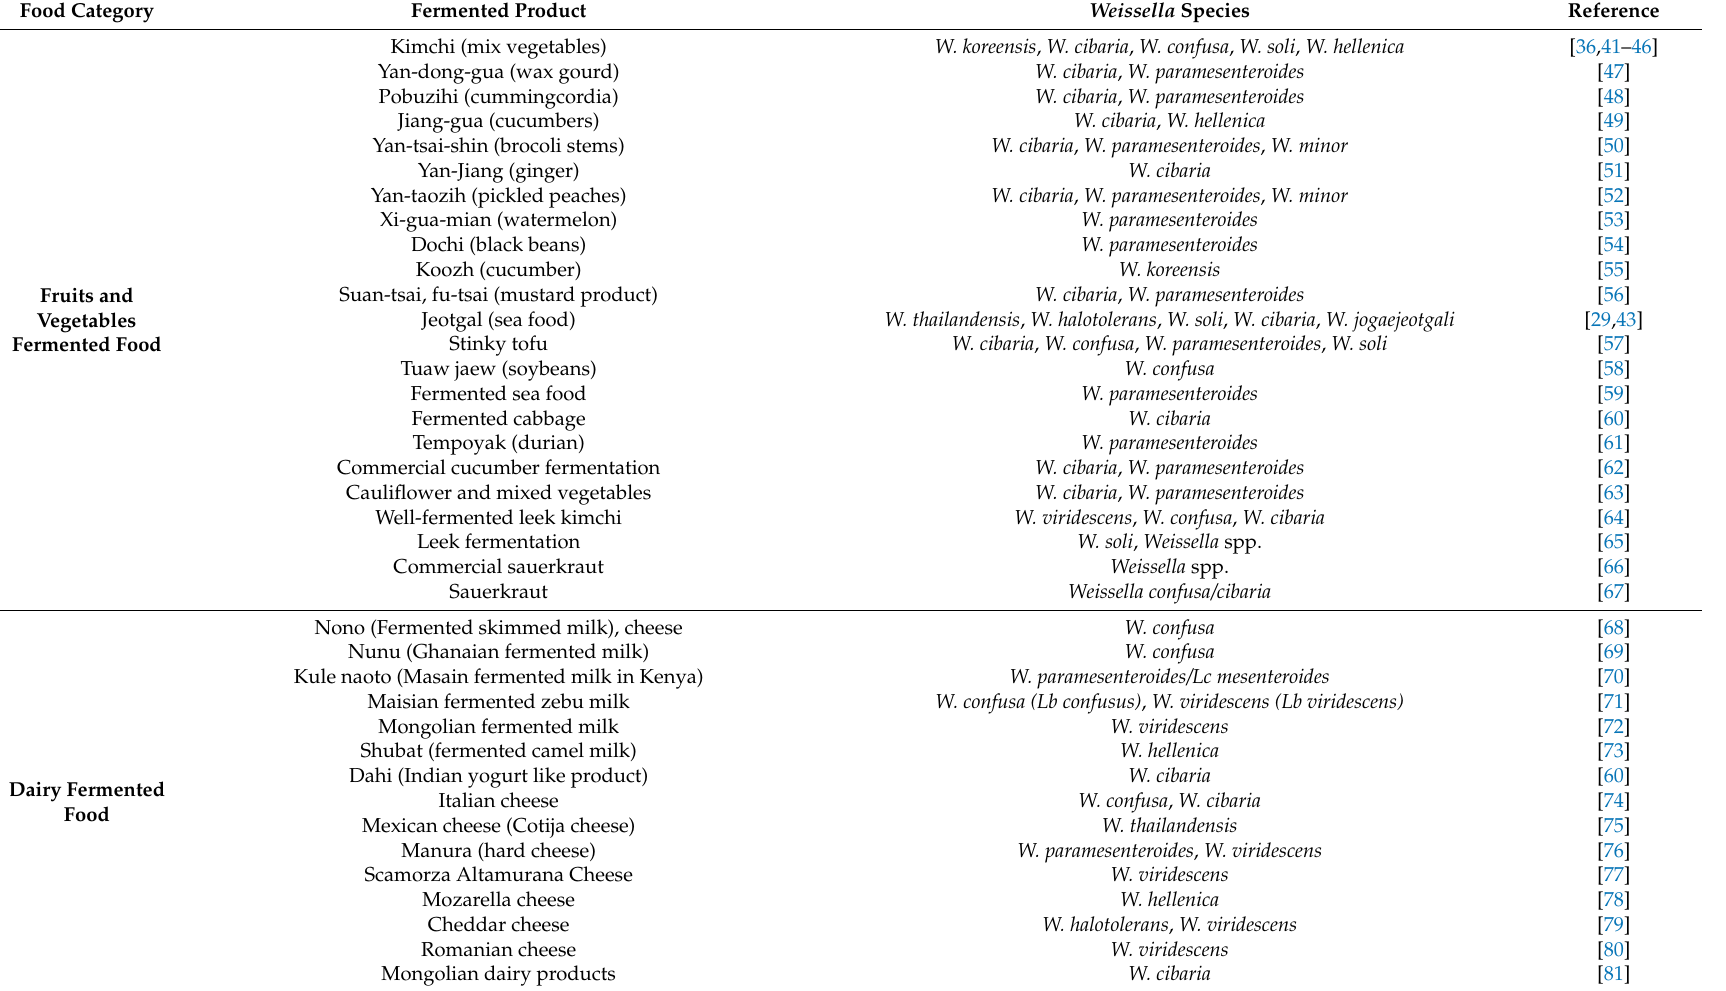
Table 2. Detection of Weissella spp. in fermented